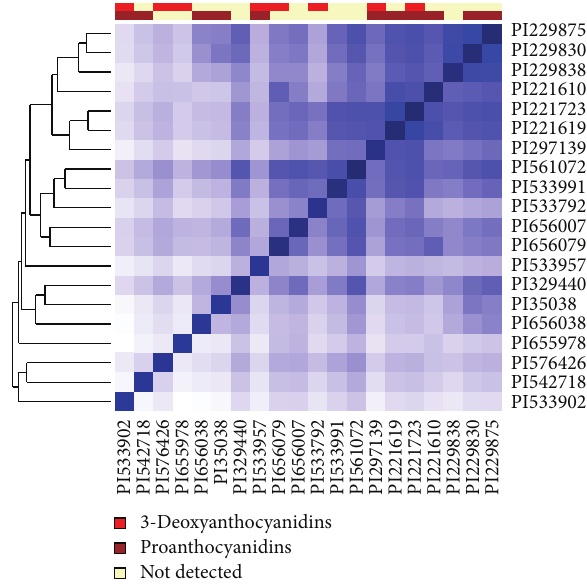
Figure 1: Heatmap and dendrogram of hierarchical clustering showing the estimated kinship among 20 sorghum accessions. Genetic relatedness between accessions was calculated in a kinship matrix using a unified mixed linear model in GAPIT. The darker the blue, the more related the accessions. The presence or absence of proanthocyanidins and 3-deoxyanthocyanidins is indicated in the top two